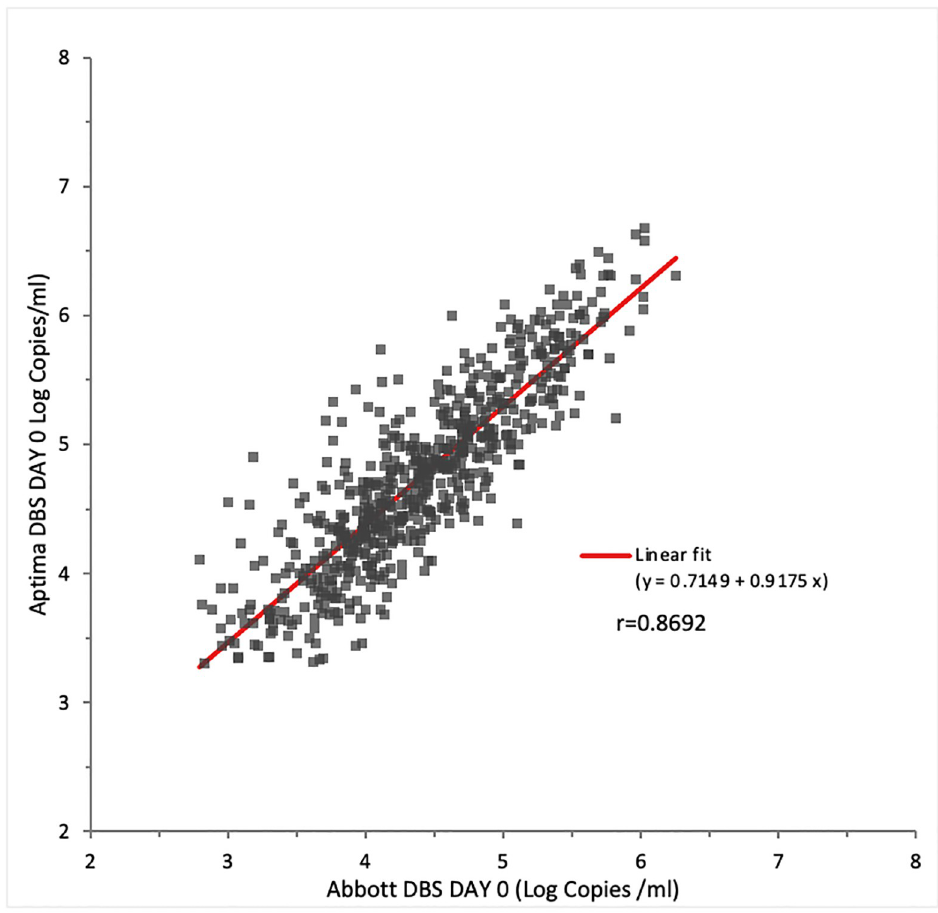
Fig 3. HIV VL comparison in fresh DBS tested in Aptima and Abbott RT